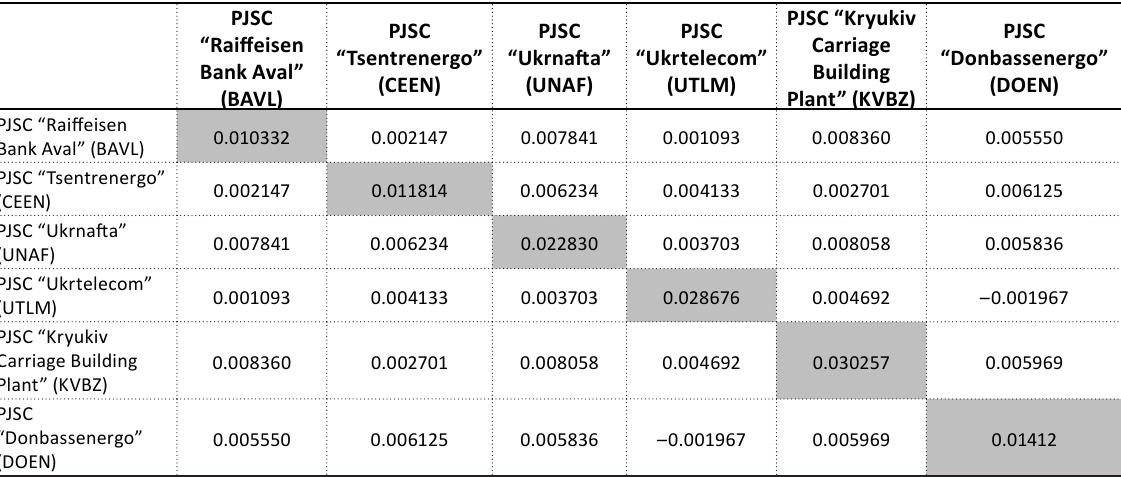
Table 6. Covariance matrix for conventional